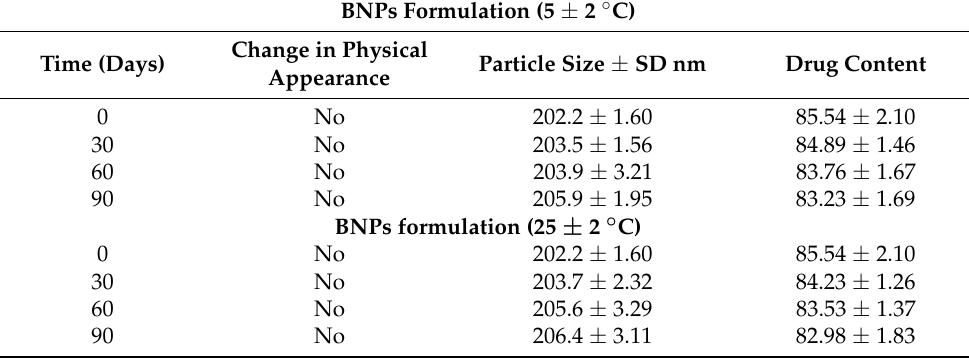
Table 4. Stability